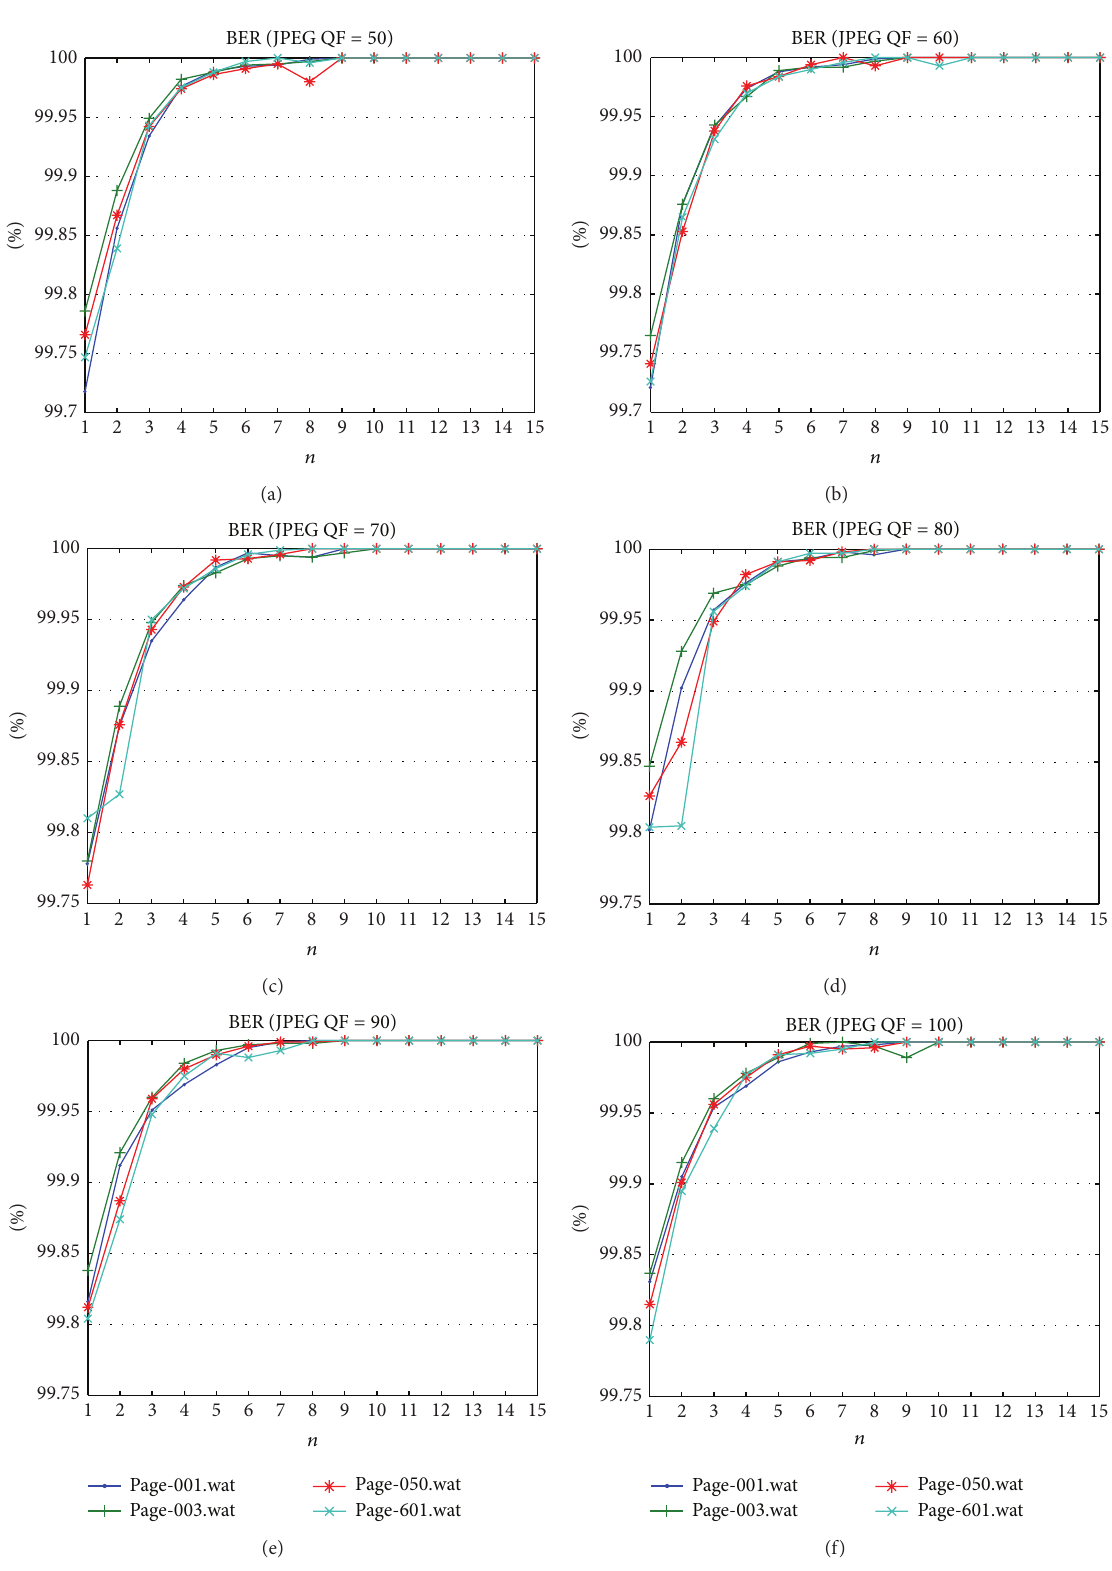
Figure 18: Bit error rate result against JPEG compression, QF = [50, 100]